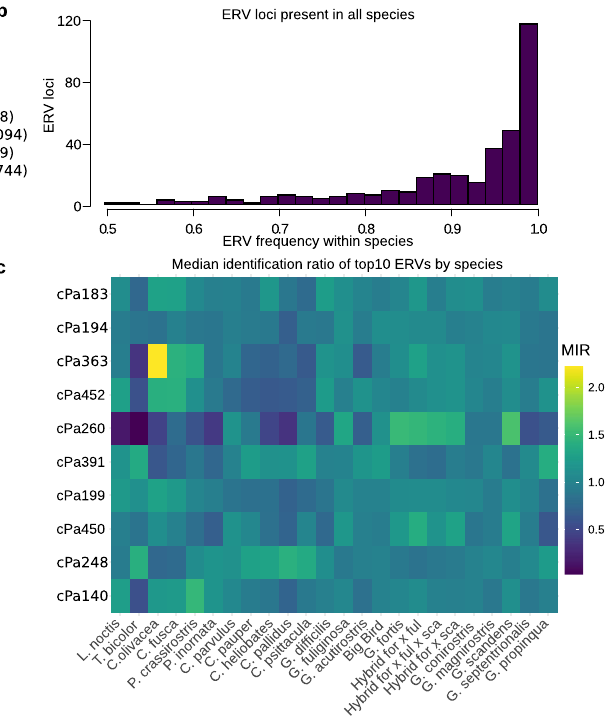
Fig. 3 | ERV phylogeny and heatmap. a Phylogeny of ERVs from the genome assembly together with retrovirus- and ERV-reference sequences establish evolu- tionaryrelationshipsandfacilitateconstructionofacuratedERVmappinglibraryto match unassembled short read sequences for ERV localizations along host DNA. FullphylogenetictreeisavailableinSupplementaryData2. b Frequencyhistogram